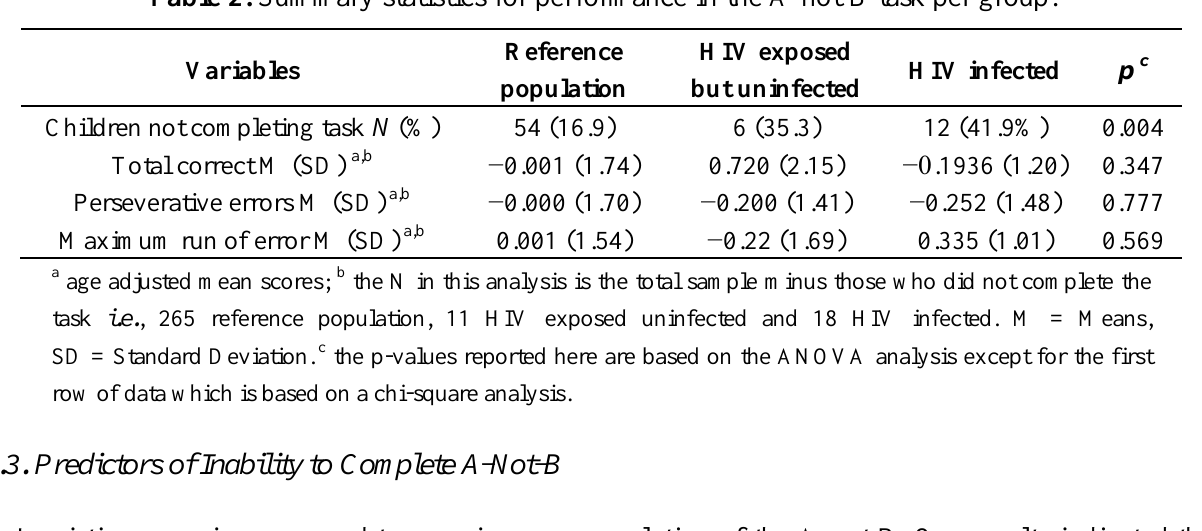
Table 2. Summary statistics for performance in the A-not-B task per group.